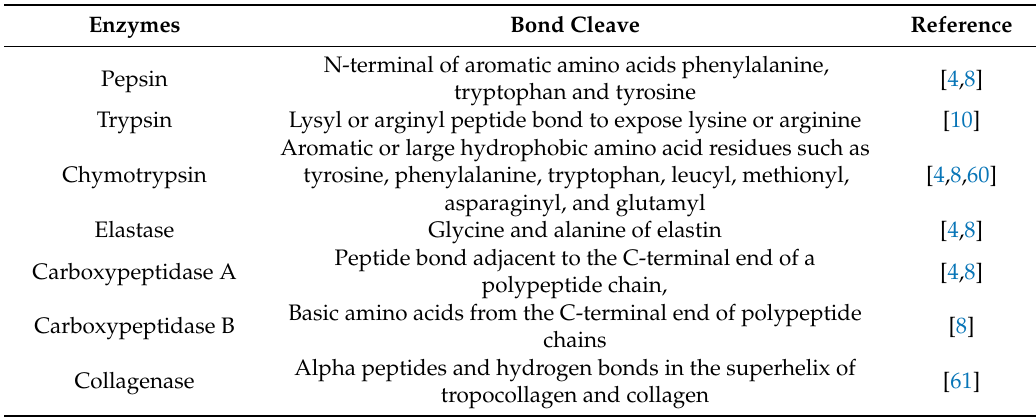
Table 1. Enzyme and their specific bond cleavage